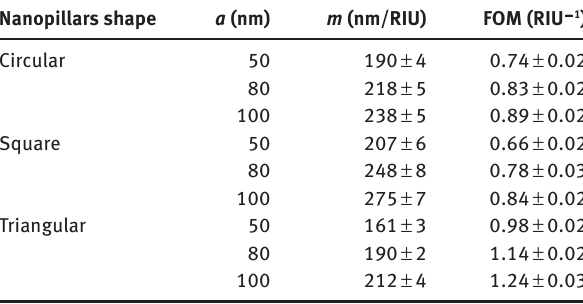
Table 1: FOM and bulk refractive index sensitivity ( m ) estimated for ThMo nanosensors investigated using the linear fit Δ λ s = m Δ n . Nanopillars